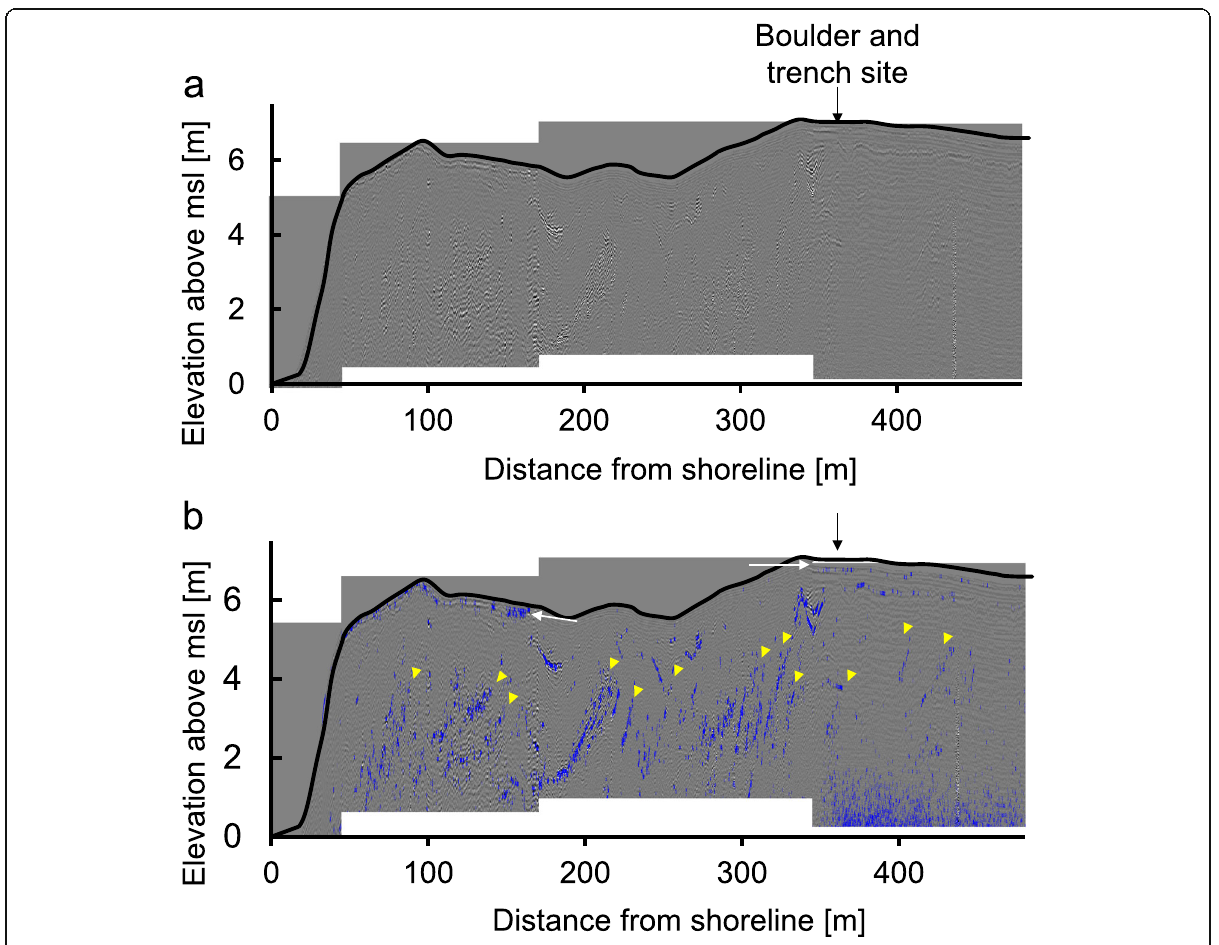
Fig. 3 Topography and GPR profile around the tsunami boulder: a profile along the GPR lines in Fig. 2b; b processed subbottom profile with interpretation. Blue dots and lines show strong reflectors in the GPR survey section. White arrows indicate reflectors that are parallel to the ground surface. Yellow arrowheads indicate reflectors that are parallel to the beach